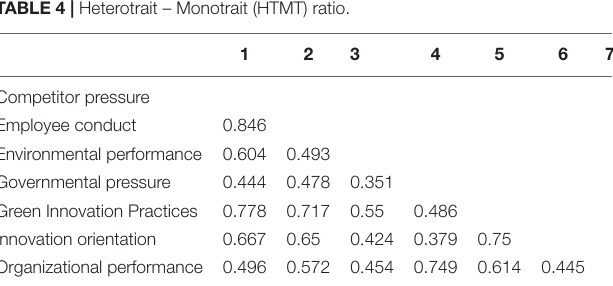
TABLE 4 | Heterotrait – Monotrait (HTMT) ratio.